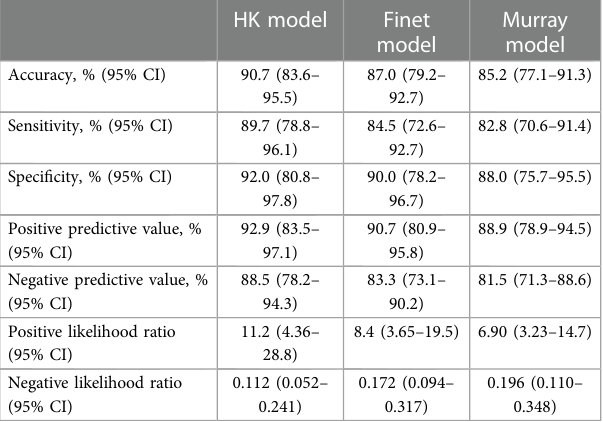
TABLE 4 Diagnostic performance of HK model, Finet model, and Murray model to identify invasive FFR ≤ 0.80.